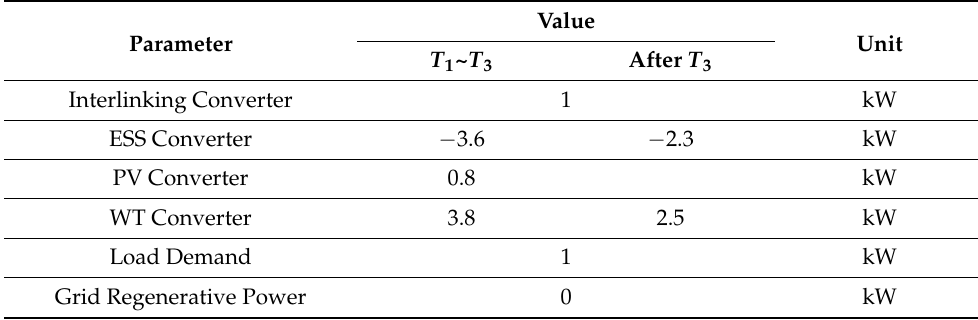
Figure 24. Experiment waveforms of operation mode 5 ( a ) Power quantity of major parts and SOC, ( b ) Voltage and current waveforms in major parts. Table 8. Power flow of each power converter in operation mode